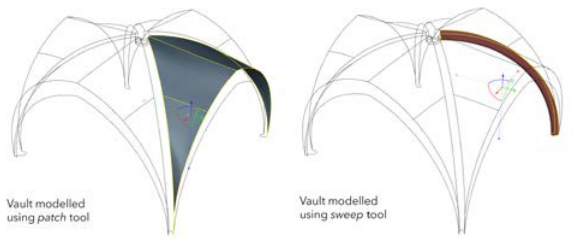
Figure 6. Modelling of the rib vault: patch tool for vaults and sweep tool for ribs